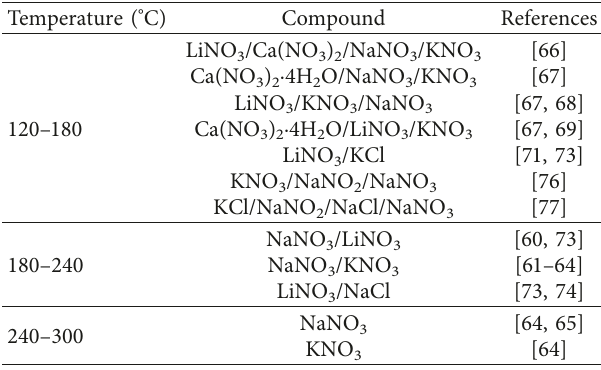
Table 3: The melting point of medium-temperature inorganic eutectic